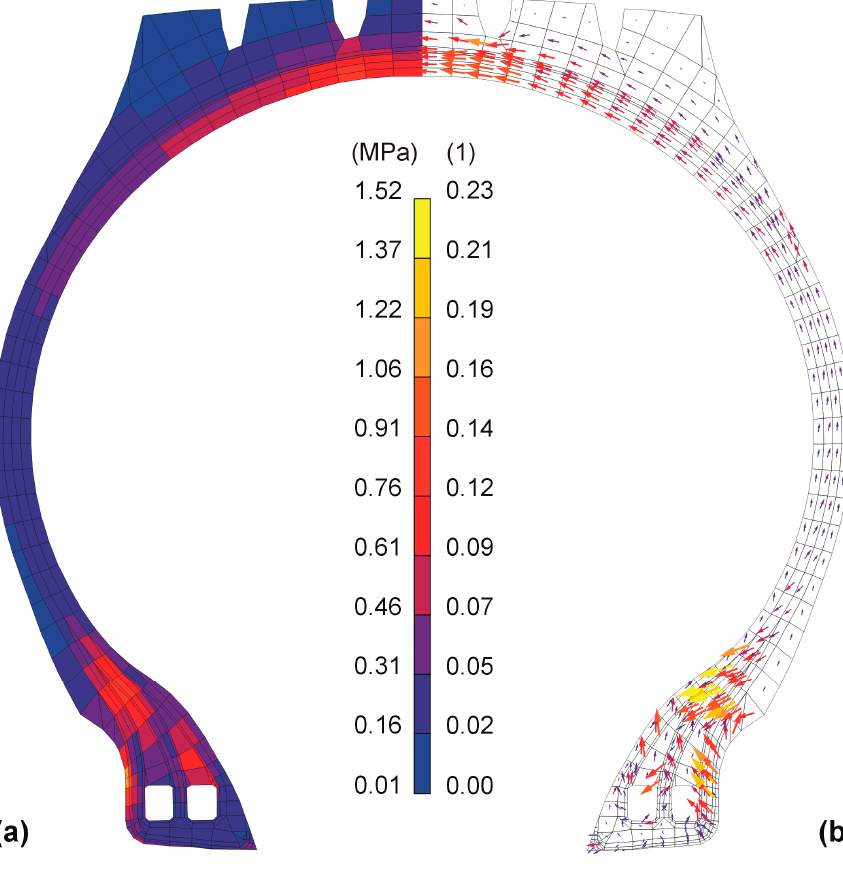
Figure 8. Inflated tire; ( a ) map of equivalent Cauchy stress in rubber, ( b ) distribution of the maximum principal strain in rubber.